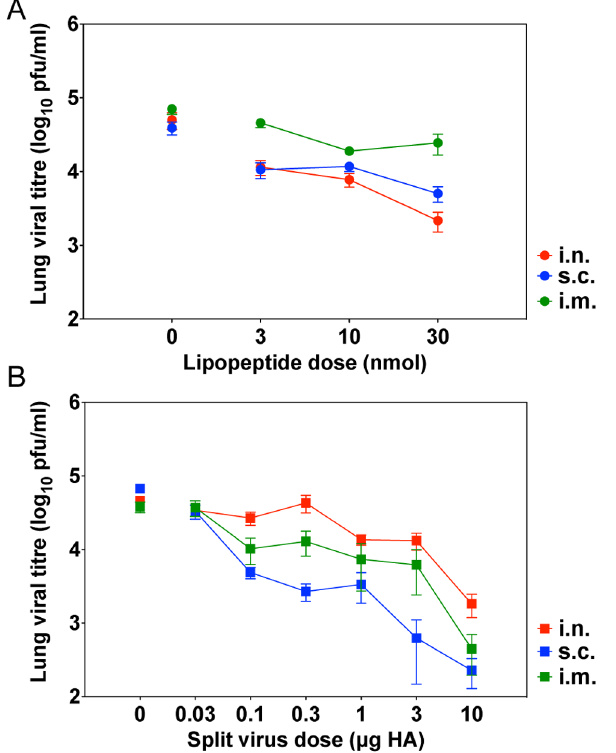
Fig. 1. Pulmonary viral clearance after vaccination with lipopeptide or split virus vaccines . Mice were immunised by the i.n. (red), s.c. (blue) or i.m. (green) route with incremental doses of either lipopeptide (A) or split virus (B) on one occasion. One month post-immunisation, mice were challenged by the i.n. route with 10 4.5 pfu of virus. The lungs were removed 5 days later and pulmonary viral titre determined by plaque formation. Symbols represent the geometric mean for the group (n 5 5) and error bars indicate the standard